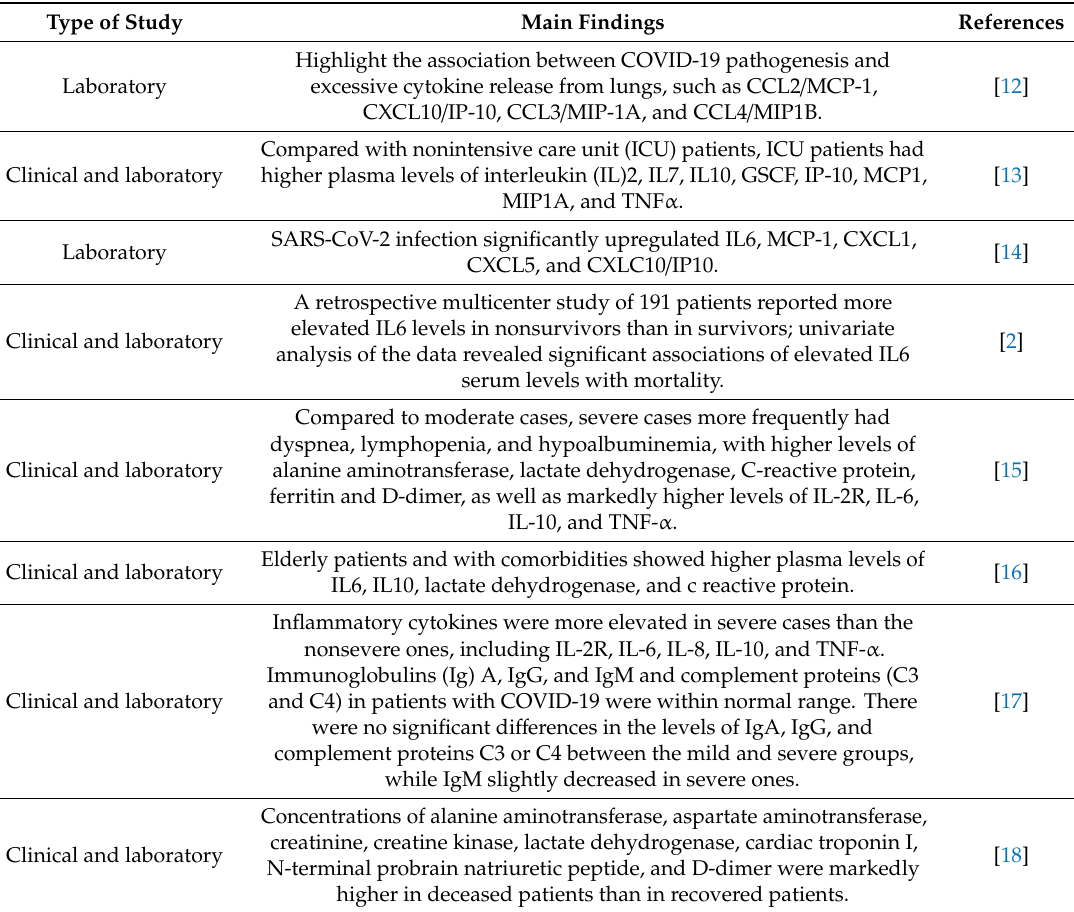
Table 1. Examples of reports of generalized immune system activation in